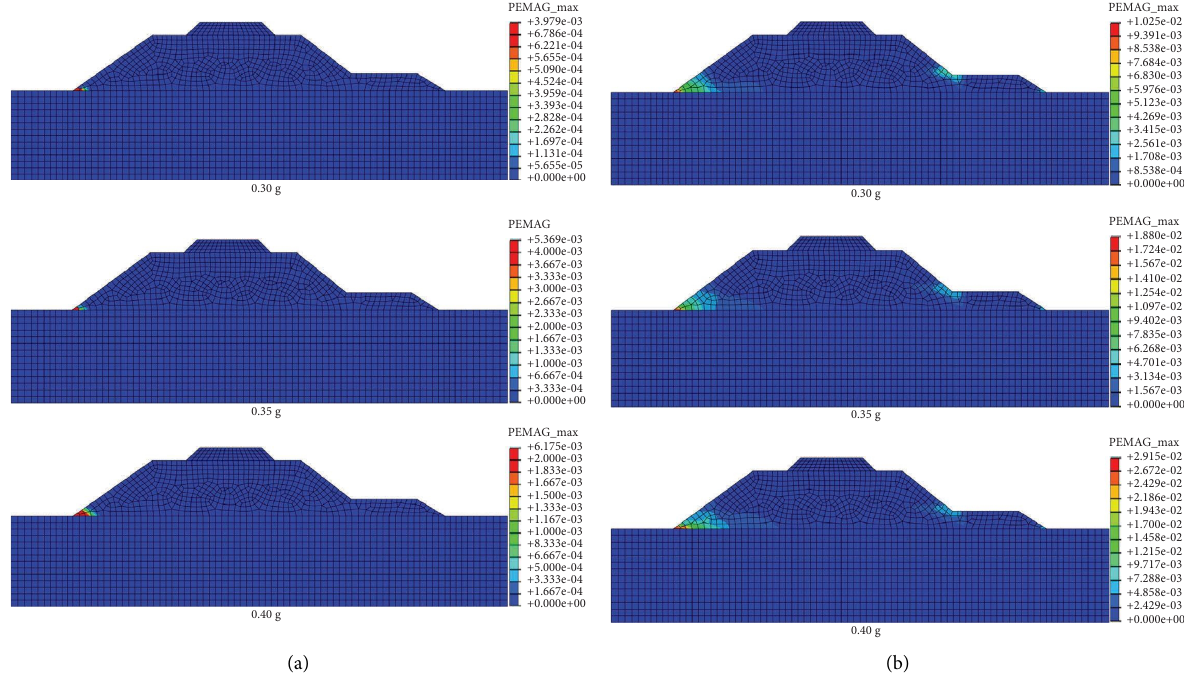
Figure 12: Te maximum plastic strain of the embankment under the seismic motion: (a) in the cold season; (b) in the warm season.